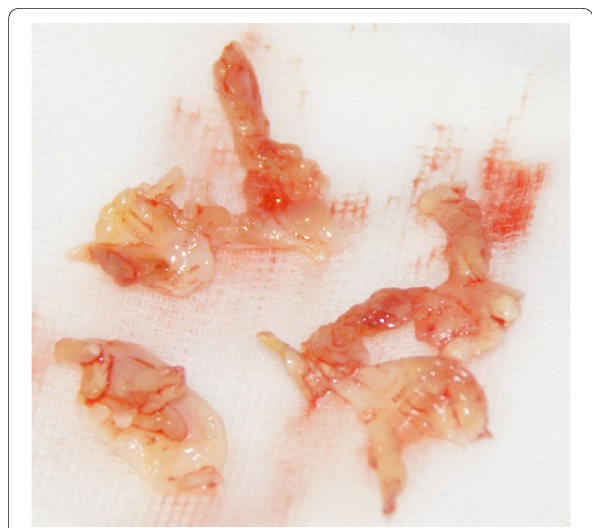
Fig. 3 Three destroyed aortic valve leaflets with large vegetation